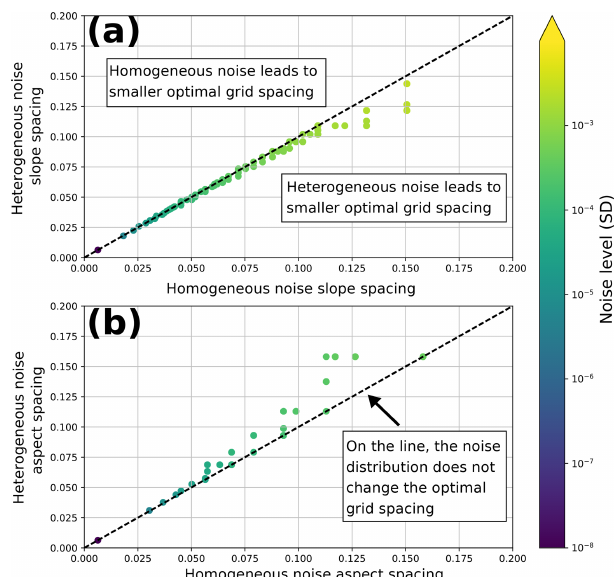
Figure 7. Optimal grid spacing for slope (a) and aspect (b) across a range of noise levels (1 e − 2 to 1 e − 8 ). Points in the upper triangle have smaller optimal grid spacings with homogeneous noise. Points in the lower triangle have smaller optimal grid spacings with hetero- geneous noise. Points on the dashed line have the same optimal grid spacings regardless of the noise distribution. Heterogeneous noise leads to smaller slope grid spacings but larger aspect spacings for the same average noise